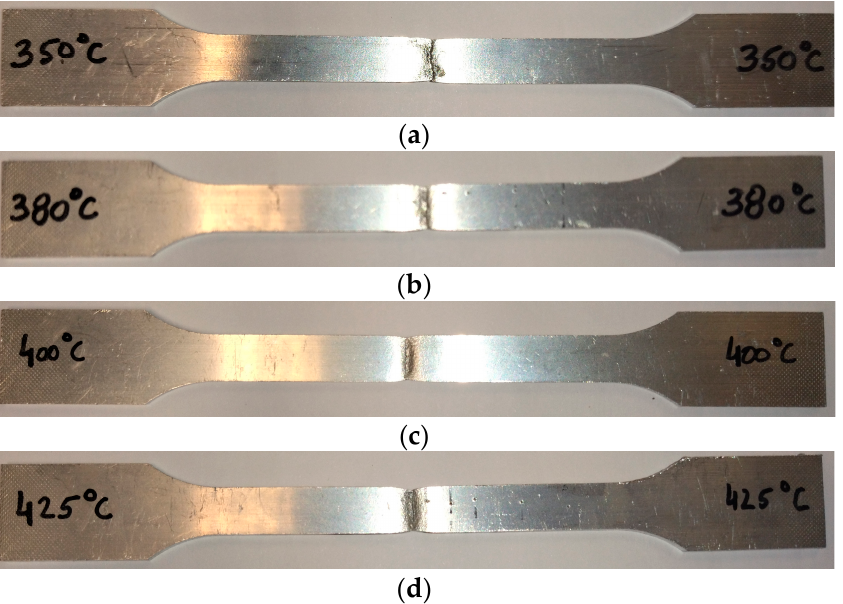
Figure 7. Fractured specimens by uniaxial tensile tests at a maximum laser heat treatment temperature of ( a ) 350 °C, ( b ) 380 °C, ( c ) 400 °C, and ( d ) 425 °C.